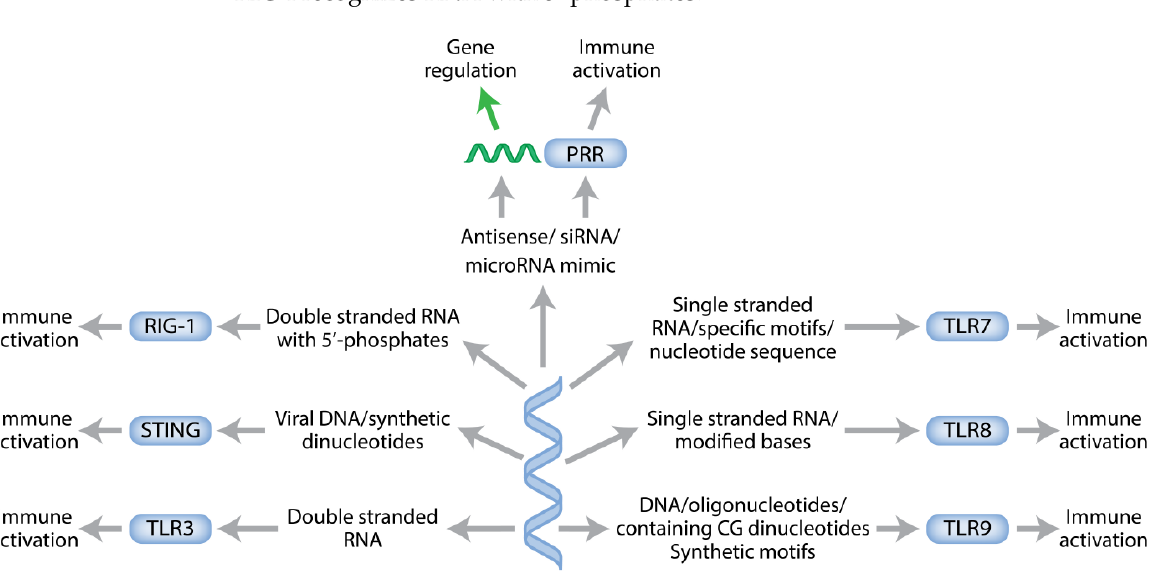
Figure 3. Pattern recognition receptors (PRRs).